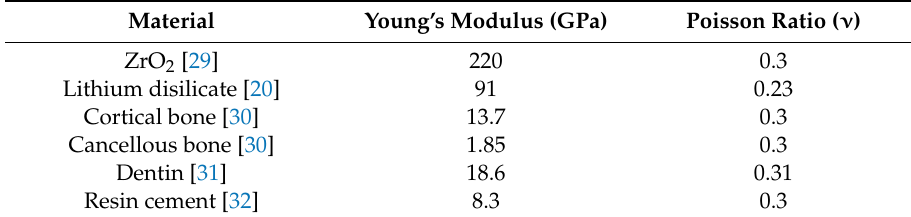
Table 1. Materials and properties of the finite element